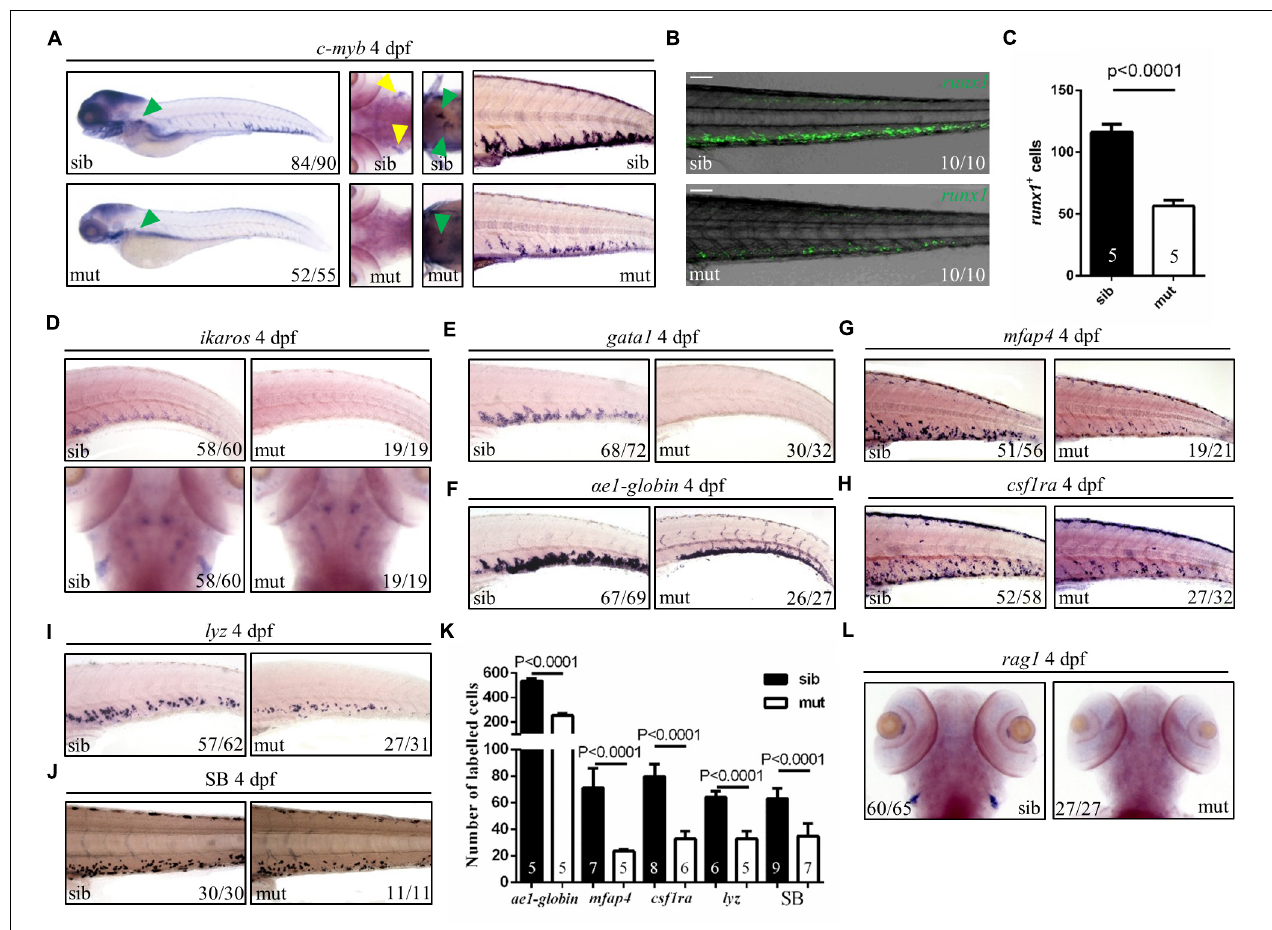
FIGURE 3 | Defects of definitive hematopoiesis in ltv1 ∆ 14 /∆ 14 mutant. (A) WISH of HSPC marker c-myb in the thymus, kidney and CHT at 4 dpf. (B) Representative confocal images of ltv1 ∆ 14 /∆ 14 ; runx1:en-gfp mutants and siblings at 4 dpf. (C) Quantification of runx1 + cells of ltv1 ∆ 14 /∆ 14 ; runx1:en-gfp mutants ( N = 5) and siblings ( N = 5) at 4 dpf. Bars represent means with SD. (D) WISH of HSPC marker ikaros in the CHT and thymus at 4 dpf. (E–I) WISH of erythrocyte progenitor marker gata1 (E) , erythrocyte marker α e1-globin (F) , macrophage markers mfap4 (G) and csf1ra (H) , and neutrophil marker lyz (I) in the CHT at 4 dpf. (J) Sudan Black-stained neutrophils in the CHT at 4 dpf. (K) Quantification of α e1-globin , mfap4 , csf1ra , lyz , and SB-positive (Sudan Black) cells in panels (F–J) , respectively. Numbers of each group are shown in the respective columns. Bars represent means with SD. (L) WISH of lymphocyte marker rag1 at 4 dpf. Yellow arrowhead: thymus; green arrowhead: kidney. Scale bar: 100 µ